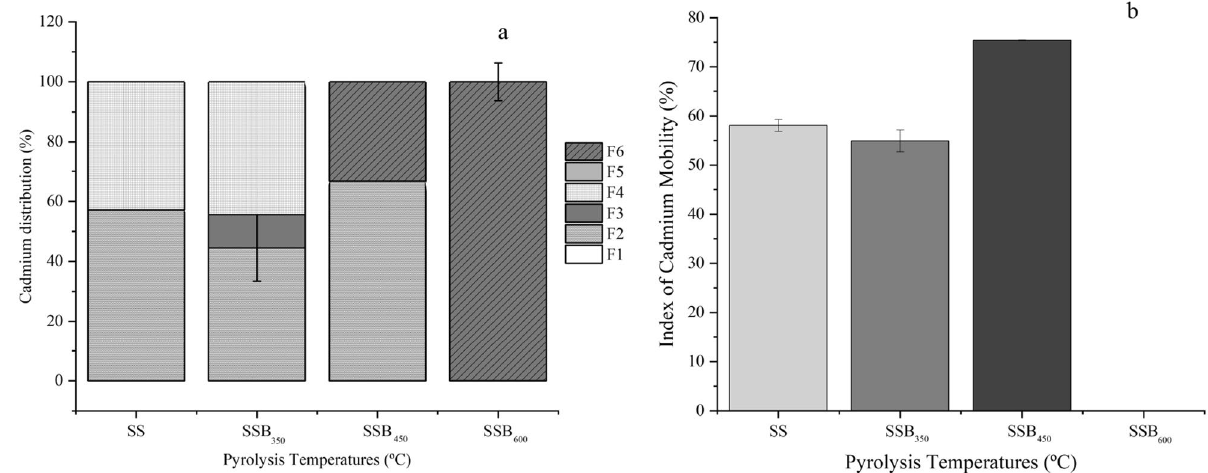
Figure 4. Cadmium fraction distribution ( a ) and mobility index ( b ) of sewage sludge biochar produced at 350 (SSB 350 ), 450 (SSB 450 ) and 600 (SSB 600 ).